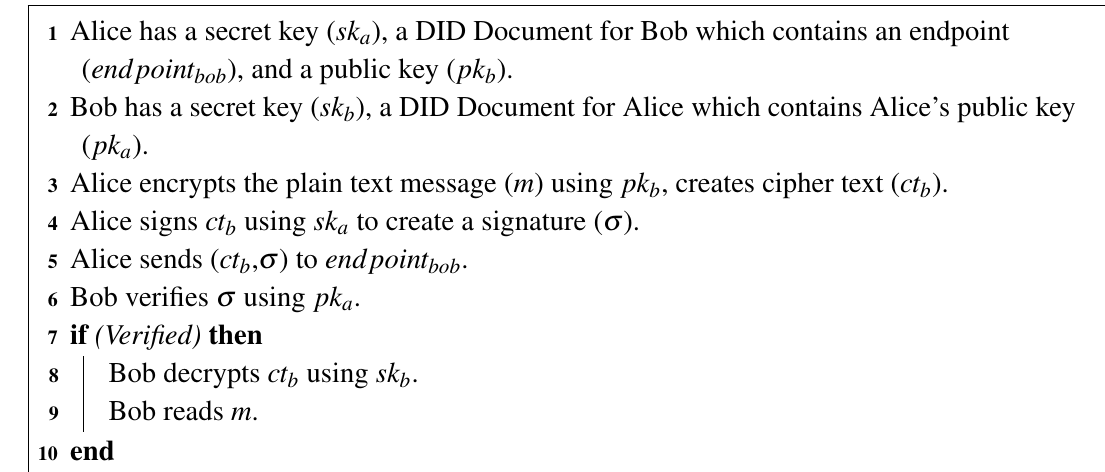
Algorithm 1: DID Communication